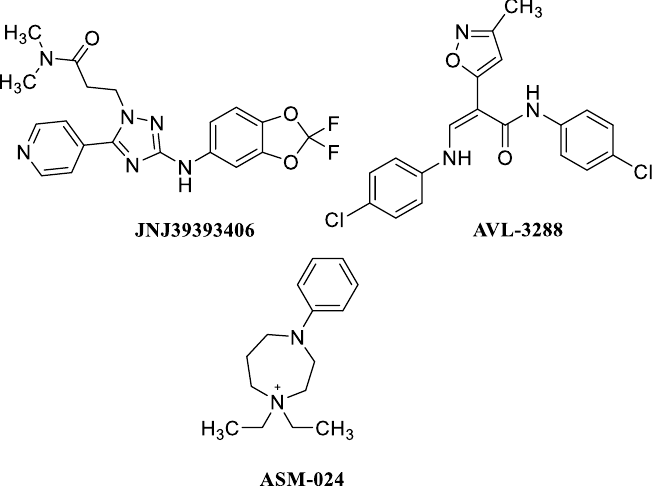
Figure 13. Nicotinic agents in clinical trials by U.S. National Institutes of Health.